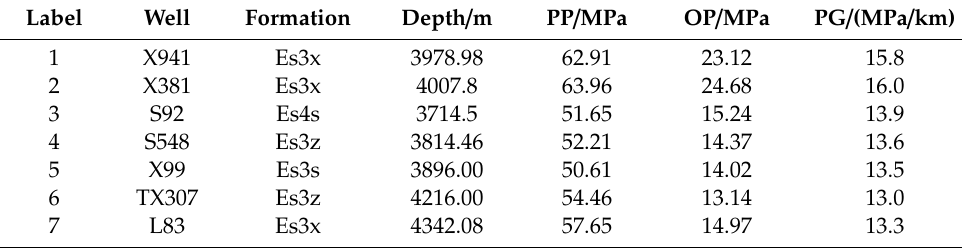
Table 1. Corresponding information about the DST overpressure data for the unloading mechanisms in Figure 9.